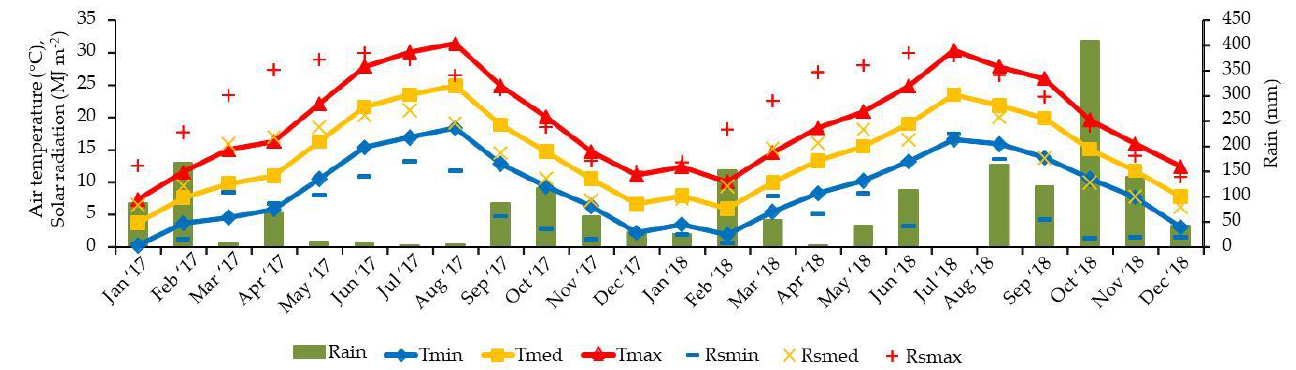
Figure 1. Monthly minimum (Rsmin), mean (Rsavg) and maximum (Rsmax) global radiation (MJ m −2 ); minimum (Tmin), mean (Tavg) and maximum (Tmax) air temperature (°C) and total rainfall (mm) in the vineyard (lat. 37°41′13′′ N; long. 15°07′00′′ E; elevation 602 m a.s.l.) in 2017 and 2018.